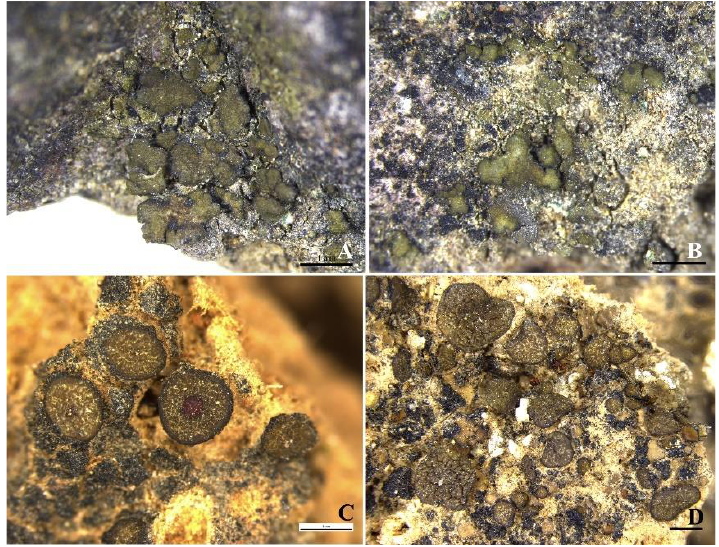
Figure 4. The thallus habit of Peltula obscuratula and P. polyspora . ( A , B ) Squamulose thallus of P. obscuratula (HMAS-L 154747, 154748). ( C , D ) Squamulose thallus of P. polyspora (HMAS-L 154723). Bars: ( A − D ) = 1 mm.